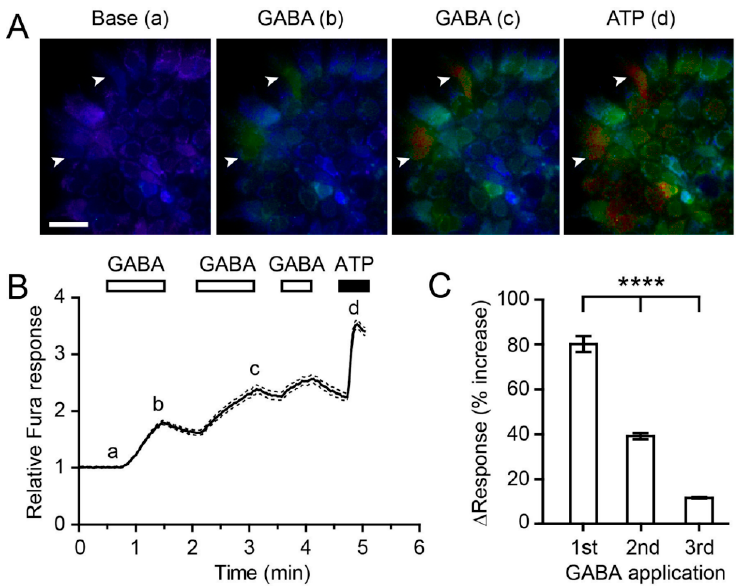
Figure 2. Exogenous gamma-aminobutyric acid (GABA) application increases the intracellular Ca 2+ levels in pancreatic β -cells. ( A ) Representative pseudo-color images of the relative Fura ratios obtained at different time points, a to d, as indicated in ( B ); higher relative Fura responses are indicated by the red color. Arrowheads indicate two cells responding to GABA (time point b and c) and ATP (time point d). Scale bar = 50 µm. ( B ) Time-dependent changes in the normalized Fura ratio following the applications of GABA (500 µM) and ATP (100 µM). Mean (solid line) ± SEM (dashed lines). ( C ) Percent increase in response to GABA relative to the relative Fura ratio immediately prior to GABA application. **** p < 0.0001, one-way repeated-measure ANOVA, n = 74.